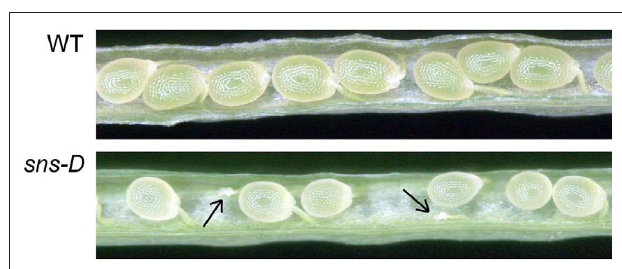
FIgURe 4 | Siliques of a wild-type and a sns-D plant. The arrows indicate